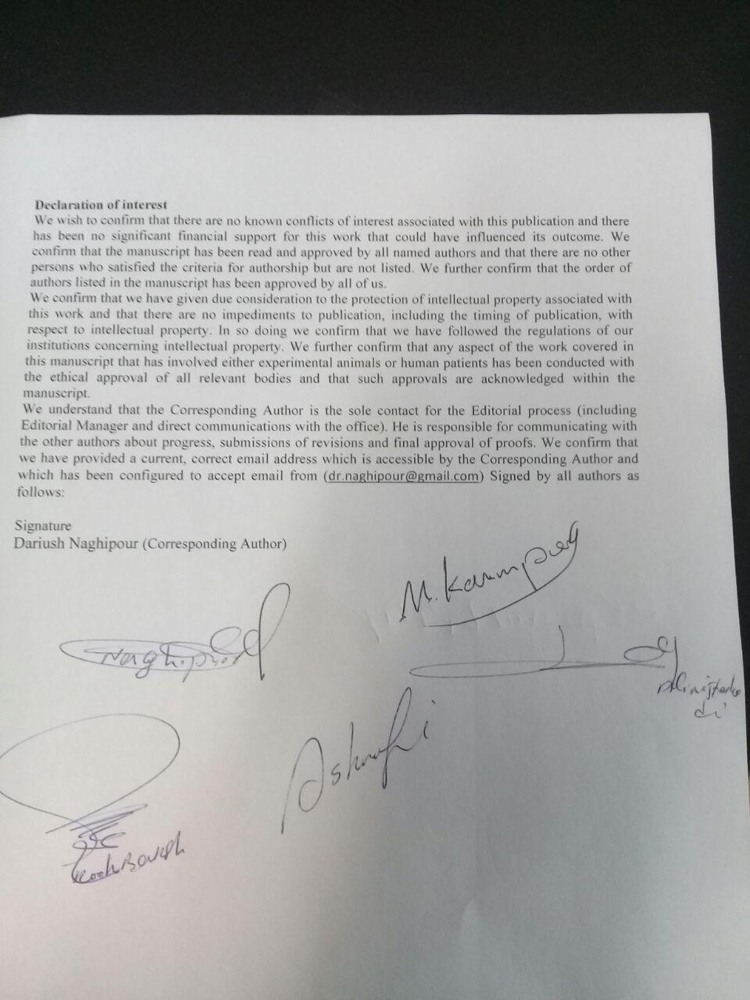
Supplementary Fig. S1.